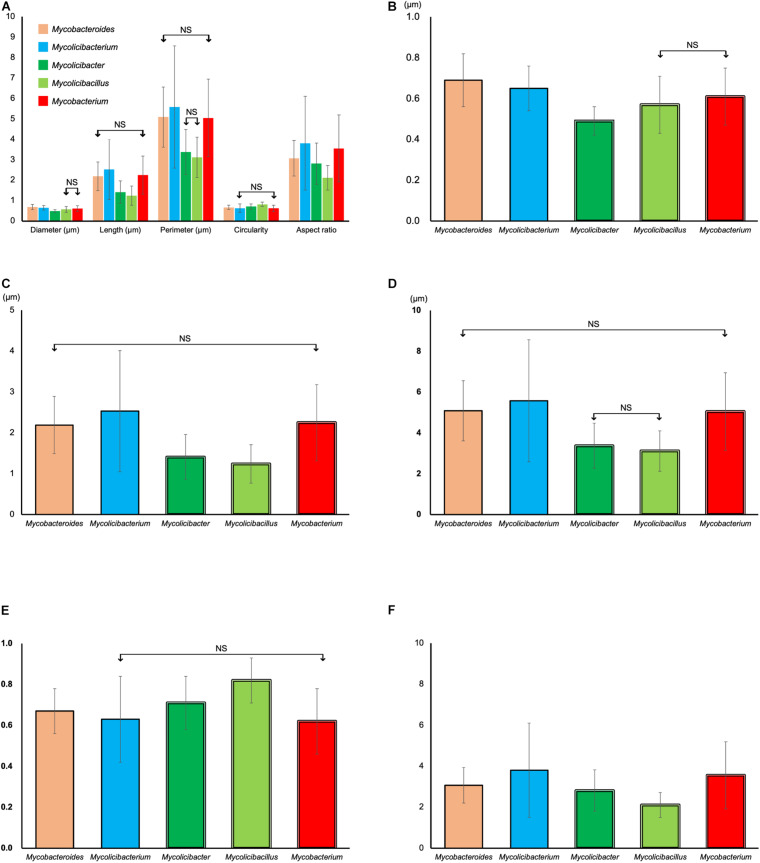
Comparison of the average of the cell diameter, the cell length, the cell perimeter, the cell circularity, and the aspect ratio between genera. (A) Overview of the whole comparison. (B) Comparison of the cell diameter between five genera. (C) Comparison of the cell length between five genera. (D) Comparison of the cell perimeter between five genera. (E) Comparison of the cell circularity between five genera. (F) Comparison of aspect ratio between five genera. Comparisons without significant difference between two genera were indicated as NS. Detail comparison data were shown in Supplementary Tables S1–S4.